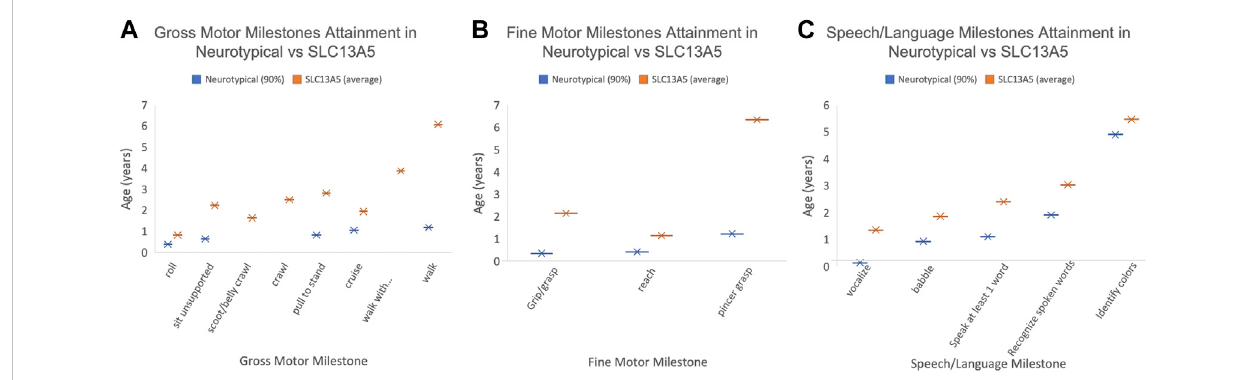
FIGURE 1 Patient developmental milestones. The 90th percentile for milestone attainment in neurotypical patients (blue, as de fi ned by the Denver Developmental Milestone Screening (Frankenburg and Dodds, 1967) compared to the average milestone attainment age for the SLC13A5 citrate transporter disorder patients. Only those patients with documentation to support the timing of milestone attainment are included. (A) Gross motor milestones. (B) Fine motor milestones. (C) Speech/language milestones. Only patients with documented milestones were used to calculate the average